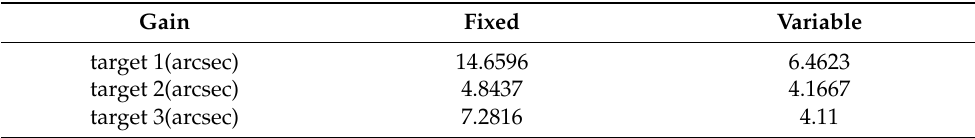
Table 3. Steady-state tracking errors of different moving targets.